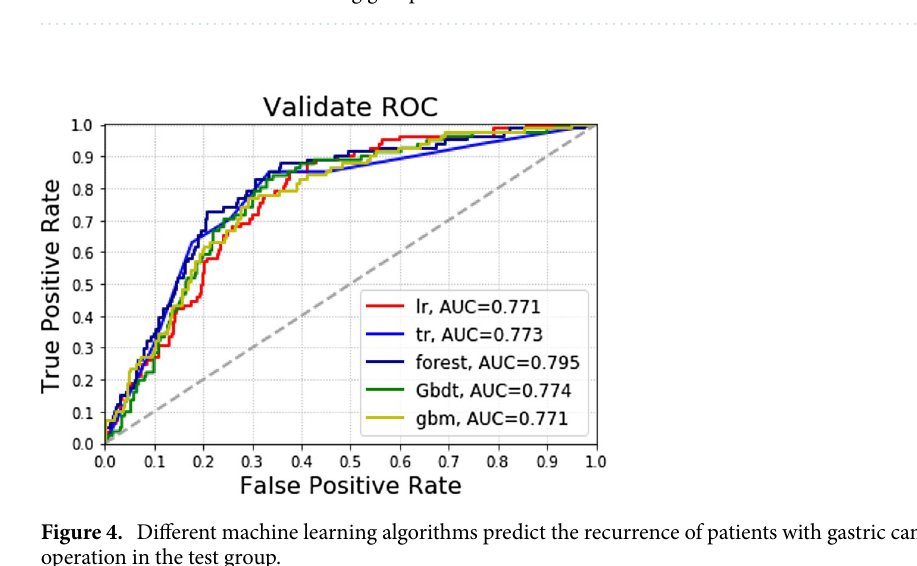
Table 3. Forecast results for testing group.